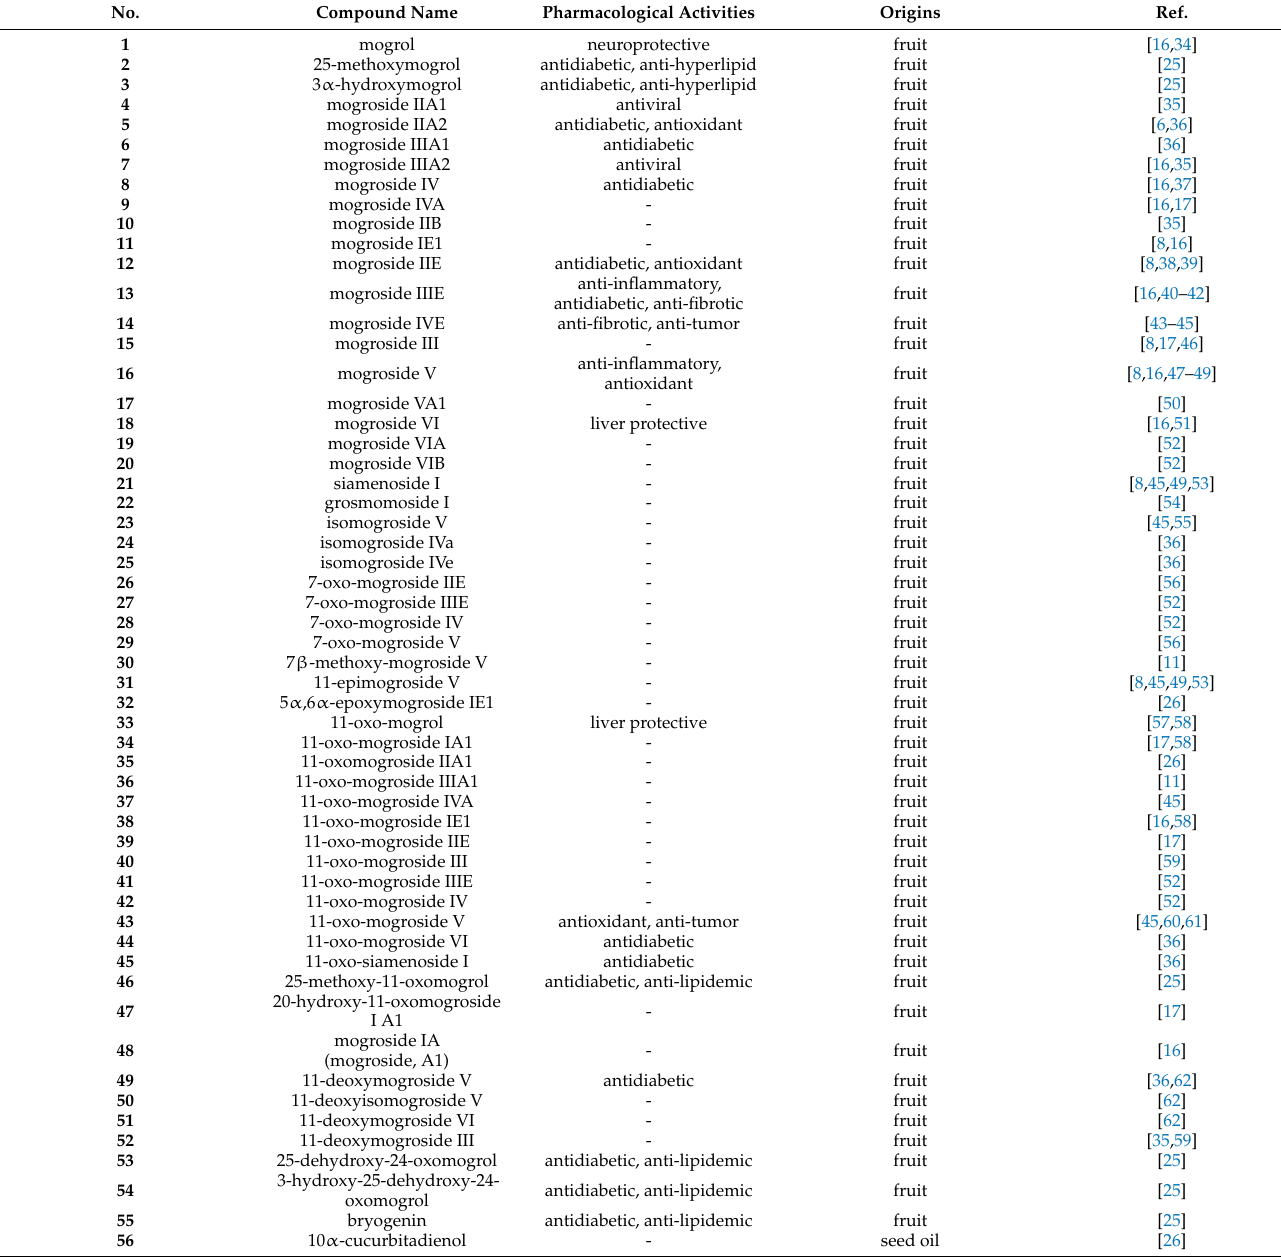
Table 1. The main cucurbitanes from S. grosvenorii